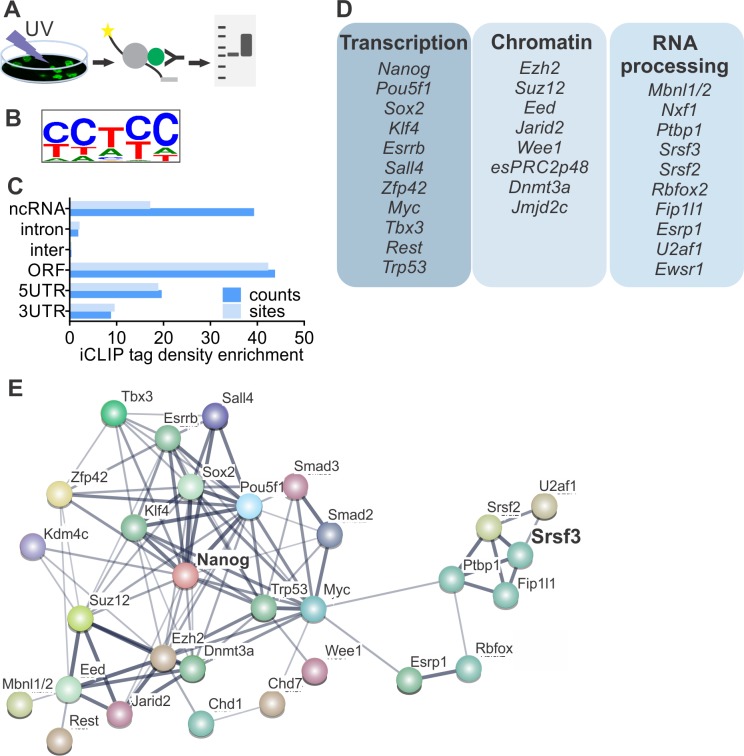
SRSF3 binds to RNAs encoding key pluripotency factors.(A) Schematic of iCLIP to determine SRSF3 binding sites in pluripotent cells. (B) SRSF3 consensus binding motif in pluripotent cells. (C) Distribution of significant SRSF3 crosslink sites (FDR < 0.05) over different transcript regions normalised to feature length. (D) SRSF3 binding sites detected in RNAs encoding key pluripotency regulators of multiple functional categories. (E) Functional association network of SRSF3 and its RNA targets in pluripotent cells. No connection between SRSF3 and the NANOG centred pluripotency network has been previously assigned. Pluripotency regulators that were directly bound by SRSF3 were used as input for STRING (Szklarczyk et al., 2015). The pluripotency associated transcription factors and chromatin modifiers were based on Young (2011) and mRNA processing factors based on Chen and Hu (2017). The thickness of the line reflects the confidence level for the interaction (highest 0.9 – high 0.7 – medium 0.4 – low 0.15), large nodes represent proteins with some structural information. See also Figure 3—figure supplement 1 and Figure 3—source data 1–4.10.7554/eLife.37419.008Figure 3—source data 1.iCLIP peaks for SRSF3-EGFP.10.7554/eLife.37419.009Figure 3—source data 2.iCLIP peaks for EGFP-NLS.10.7554/eLife.37419.010Figure 3—source data 3.iCLIP peaks for anti-SRSF3.10.7554/eLife.37419.011Figure 3—source data 4.SRSF3 iCLIP mapping statistics.